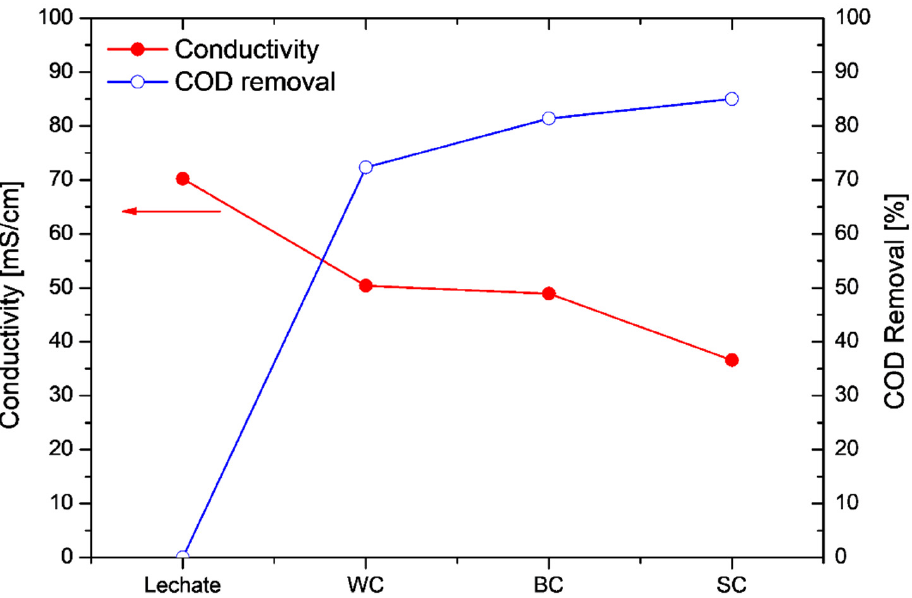
Figure 7. Conductivity measurements ( left ) and COD removal values ( right ) for the leachate and the three leachate-fed MFC configurations with different cathode electrodes.